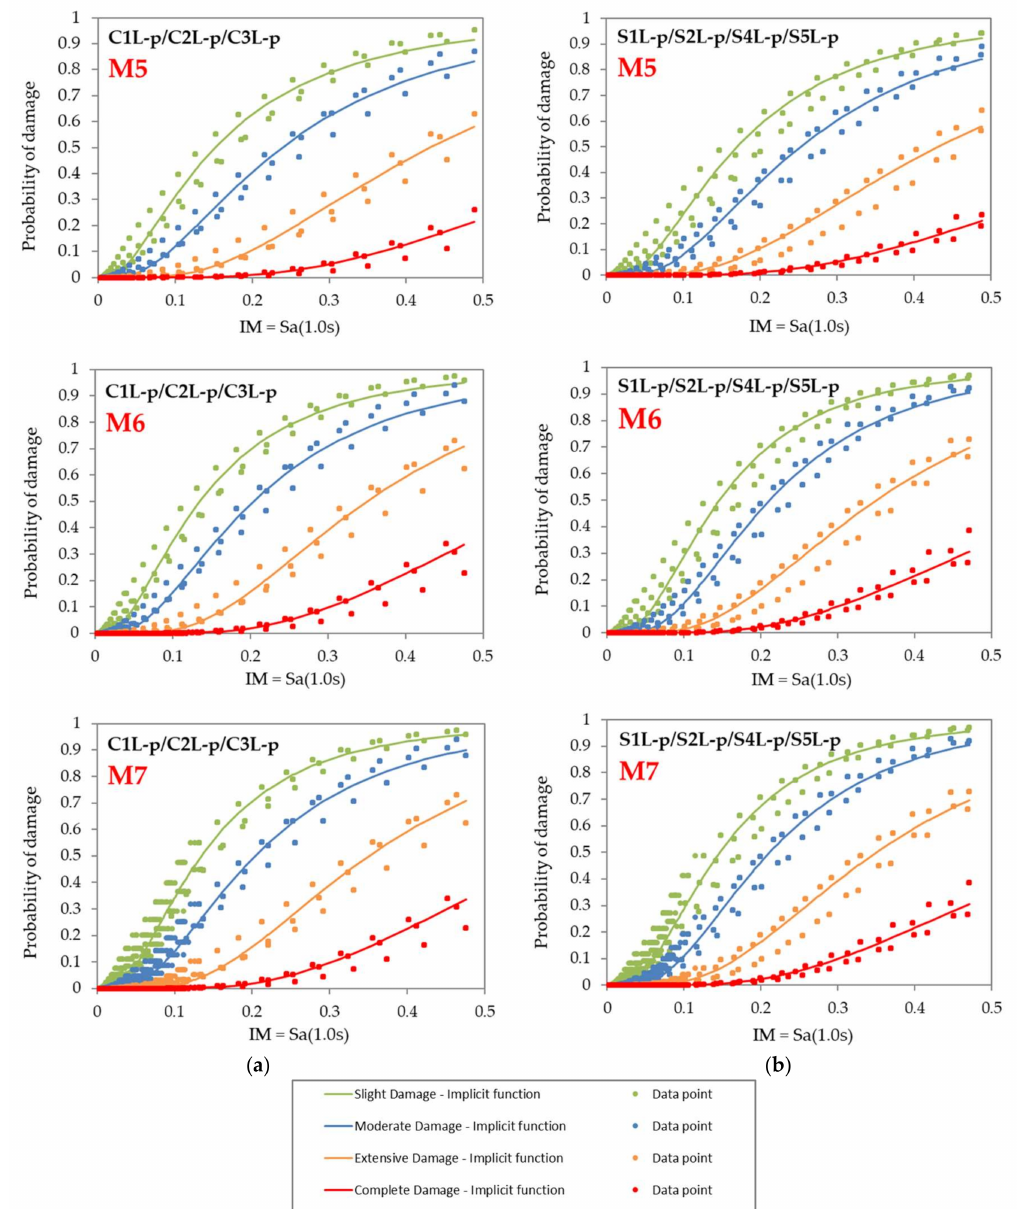
Figure 5. Implicit fragility functions for magnitudes M5, M6 and M7: ( a ) Reinforced concrete building class C (C1 + C2 + C3); ( b ) Steel building class S (S1 + S2 + S4 + S5). Continuous lines are relative to